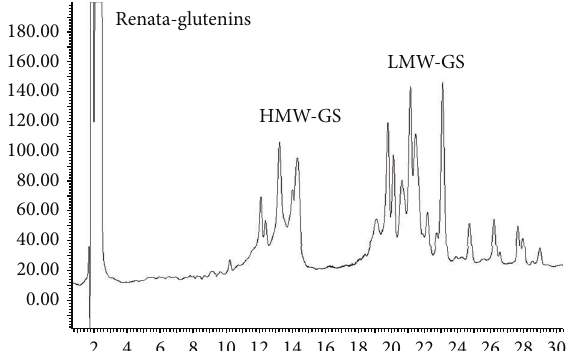
Figure 2: Chromatogram of glutenins of cultivar “Renata.”